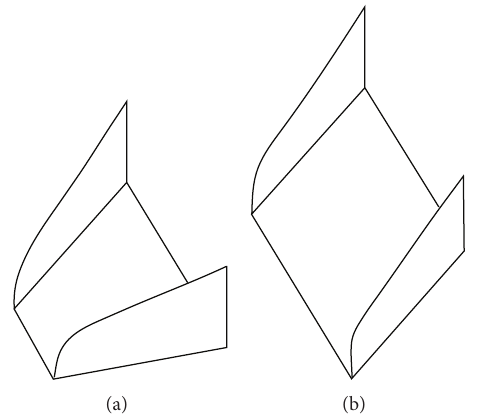
Figure 4: Vortex generator jet